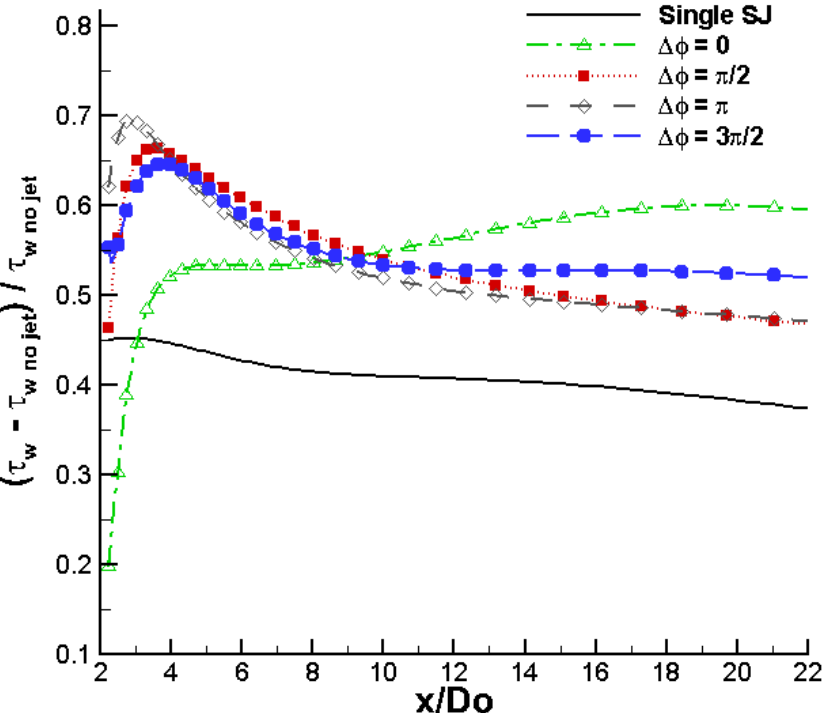
Figure 18. Mean excess wall shear stress along streamwise direction between z = − 1.6 D o ~1.6 D o .